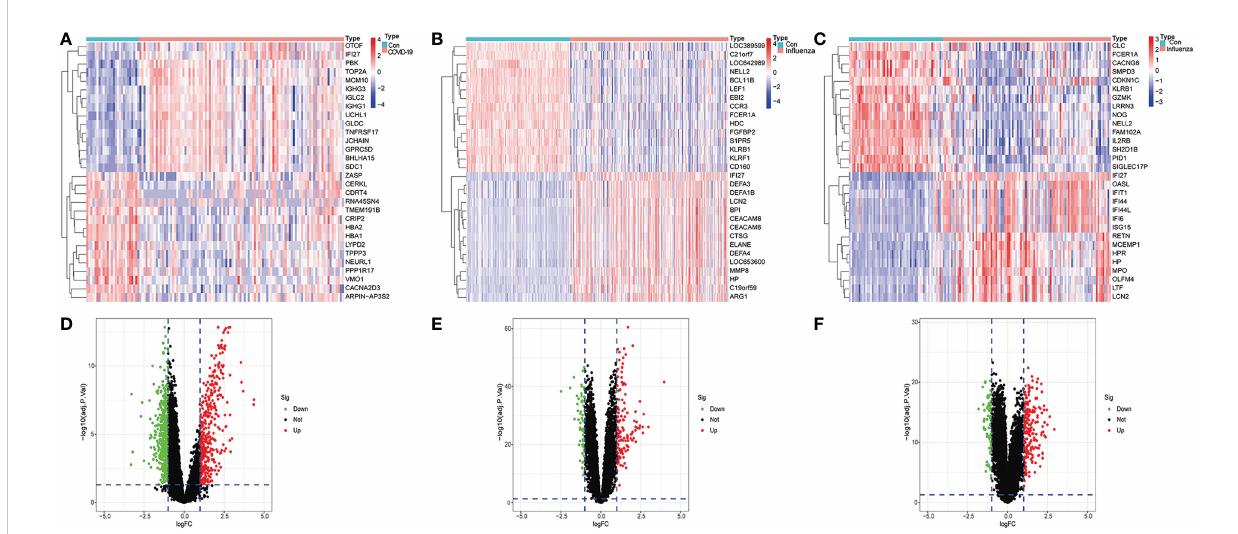
FIGURE 1 Identi fi cation of differentially expressed genes. (A) Heatmap of GSE157103 database, (B) Heatmap of GSE111368 database, (C) Heatmap of GSE101702 database, (D) Volcano of GSE157103 database, (E) Volcano of GSE111368 database (F) Volcano of GSE101702